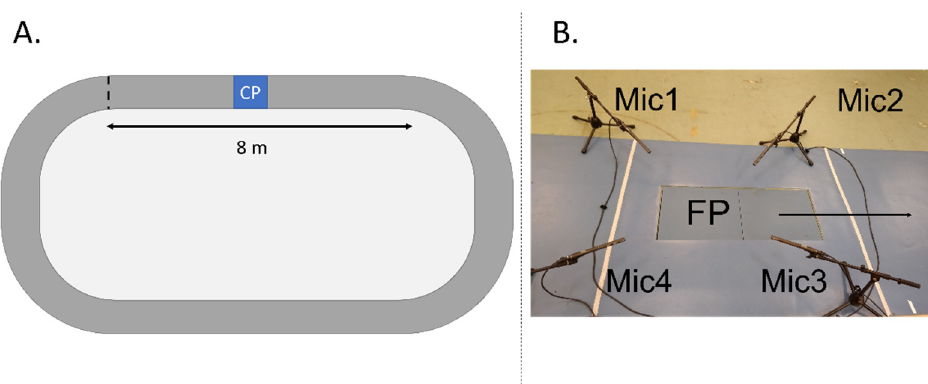
Figure 1. ( A ) Illustrative running course with a straight running line of 8 m and a caption point (CP) in the middle; ( B ) Up ‐ close illustration of the caption point with the positioning of the microphones (Mic1 ‐ Mic4) and the force plate (FP), where the arrow indicates the running